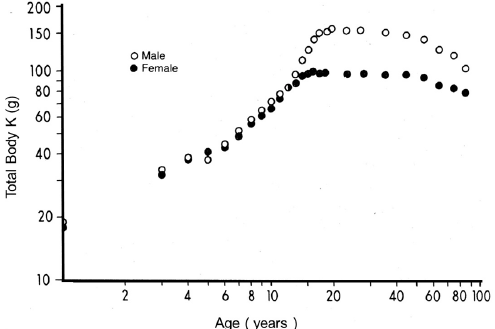
Figure 2. Evolutionary patterns of lean body mass (LBM) values throughout the human lifespan. Compilation of seven different clinical investigations performed in healthy subjects from birth to very old age and showing body accretion of total body potassium (TBK) values determined by the measurement of the naturally occurring radioisotope 40 K using dual-energy X-ray absorptiometry (DXA). The results are plotted against age on double-logarithmic coordinates. Ninety-five percent (95%) of TBK is sequestered within metabolically active tissues and narrowly correlated with total body N (TBN), making this last parameter a valuable tool to appraise LBM values in health and disease men and 90–110 g in adult women, yielding male/female K and N ratios of approximately 1.4:1.